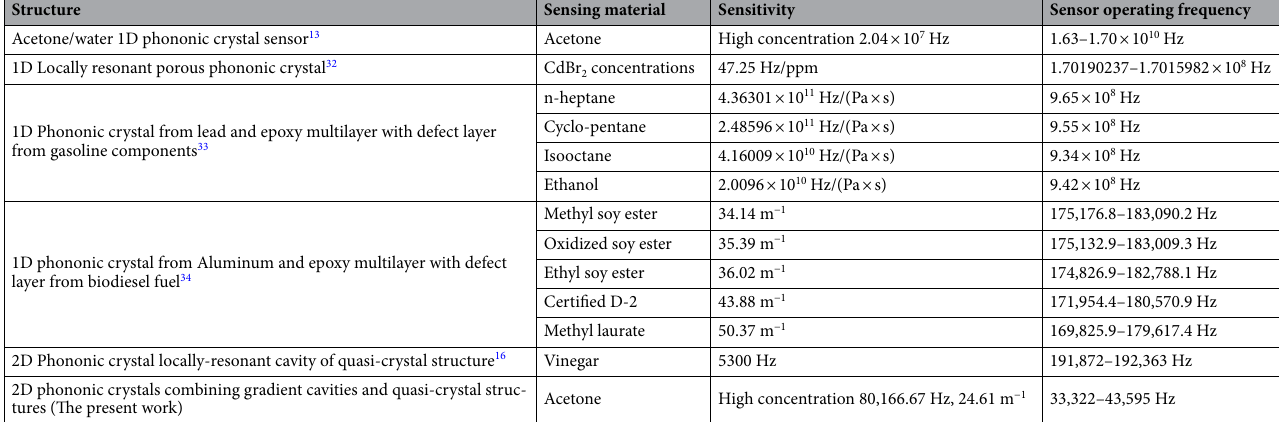
Table 4. Comparison between the sensitivity of our design with previous published